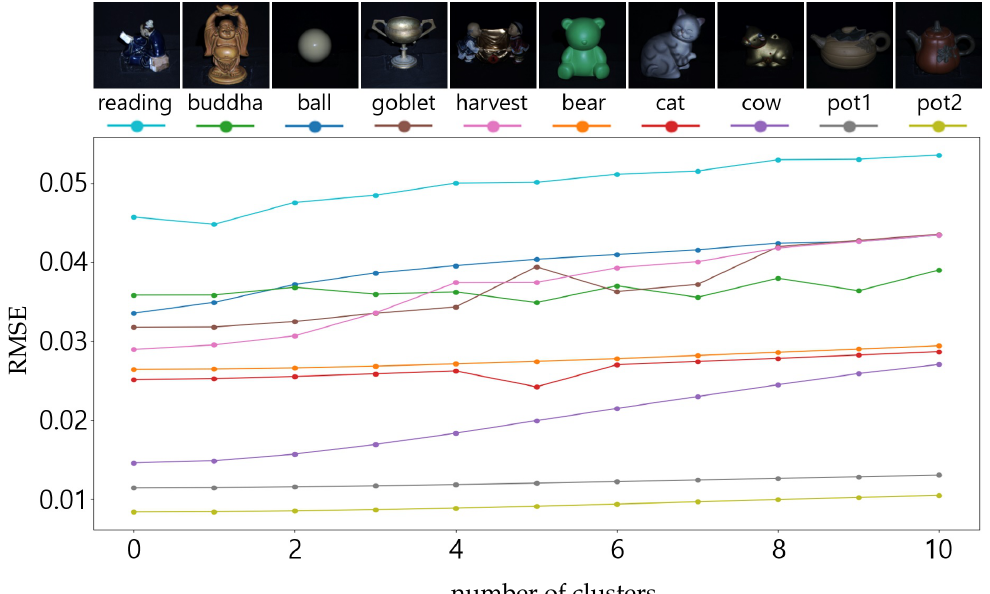
Figure 7. RMS errors in terms of the degree of uniform random noise in the surface normal. Shiny objects (reading, ball, goblet, harvest, and cow) tend to be more affected by normal perturbation. This figure is best viewed in color.